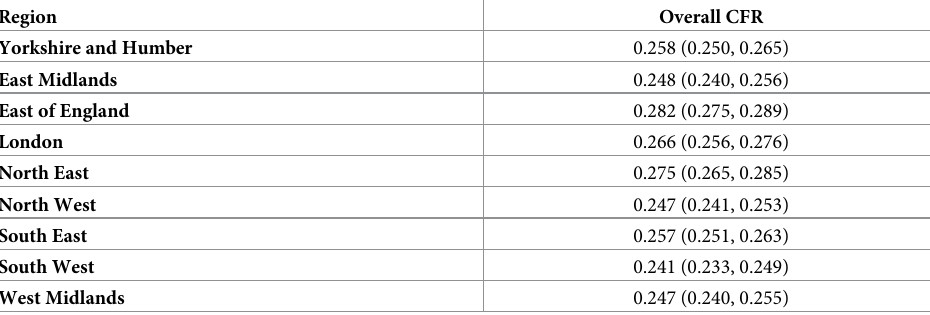
Table 1. Overall CFR as of 27/09/2021 in each region of England, using the backward method and PHE